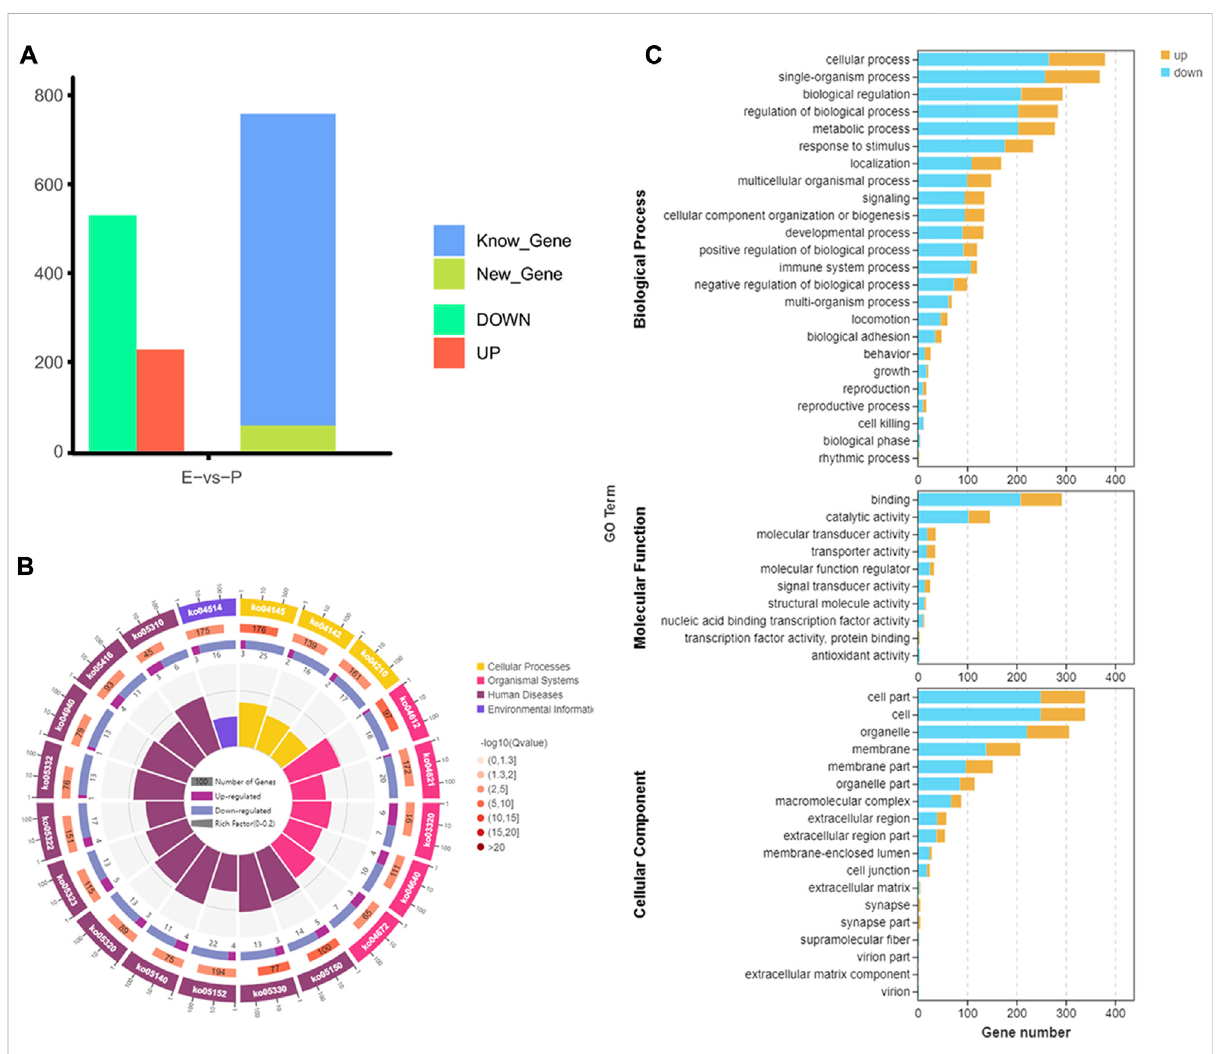
FIGURE 3 Analysis of gene expression and function in dairy goats during early and peak lactation. (A) Analysis results of gene identi fi cation at different lactation stages. (B) KEGG pathway analysis of DEGs. From inside to outside: the fi rst circle — the top 20 KEGG terms enriched, the coordinates